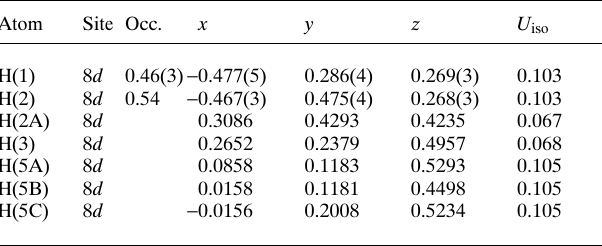
Table 2. Atomic coordinates and displacement parameters (in Å 2 )